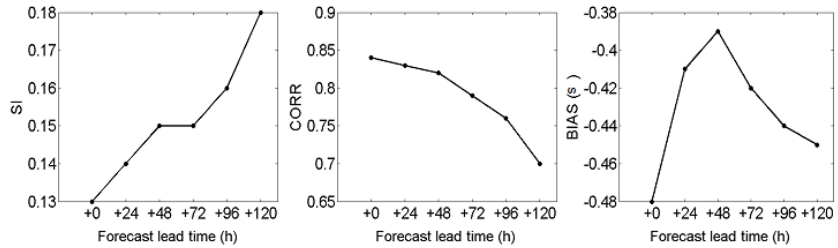
Figure 11. Med-waves T m forecast skill evaluated against buoy observations, for the full Mediterranean Sea, for a 1-year period